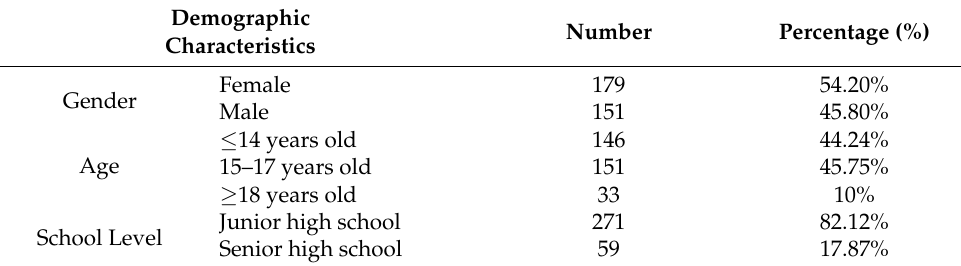
Table 1. Participant characteristics (n =